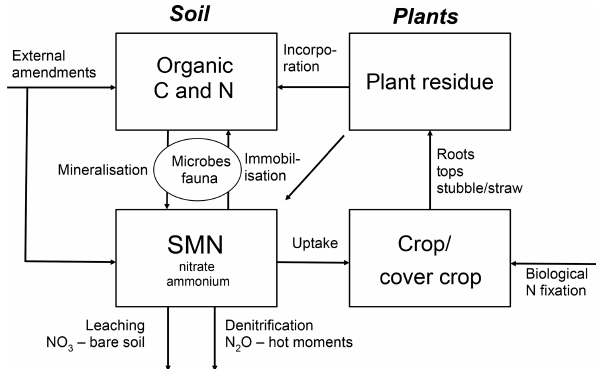
Figure 1. The principle of N dynamics in organic crop